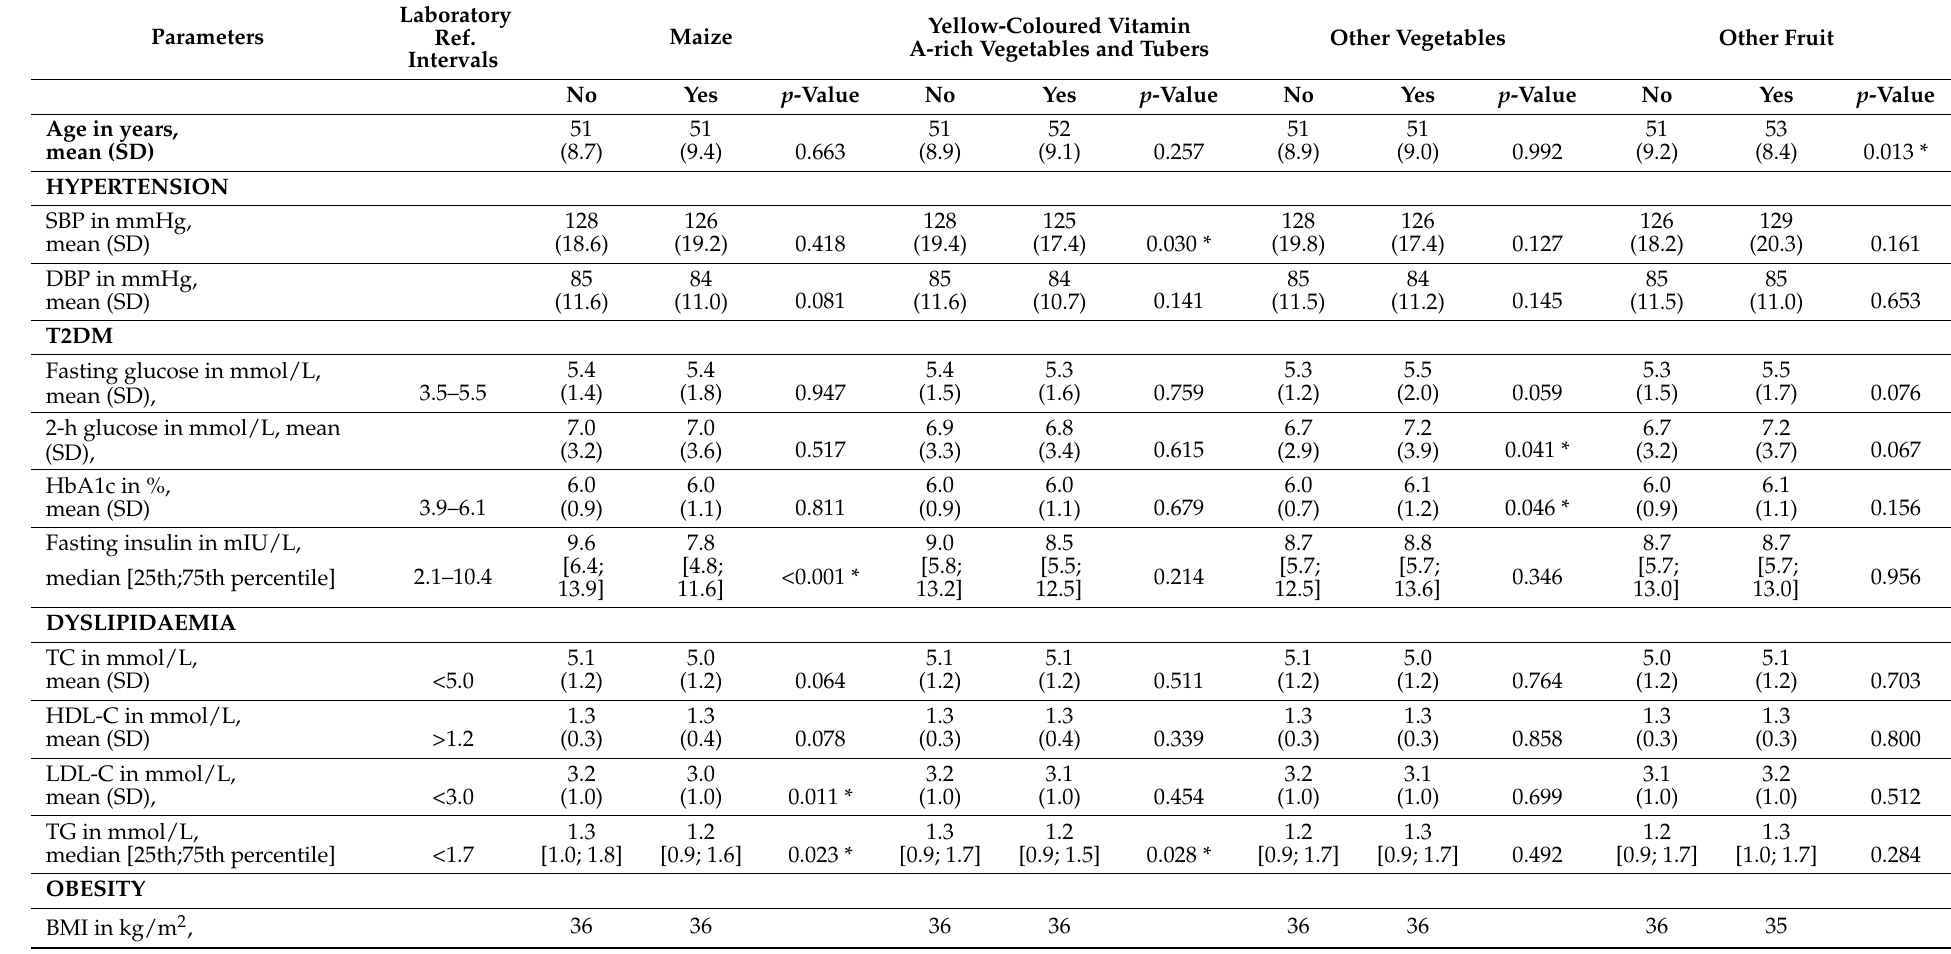
Table 3. Mean and median level of CVD risk factors in consumers and non-consumers of plant food